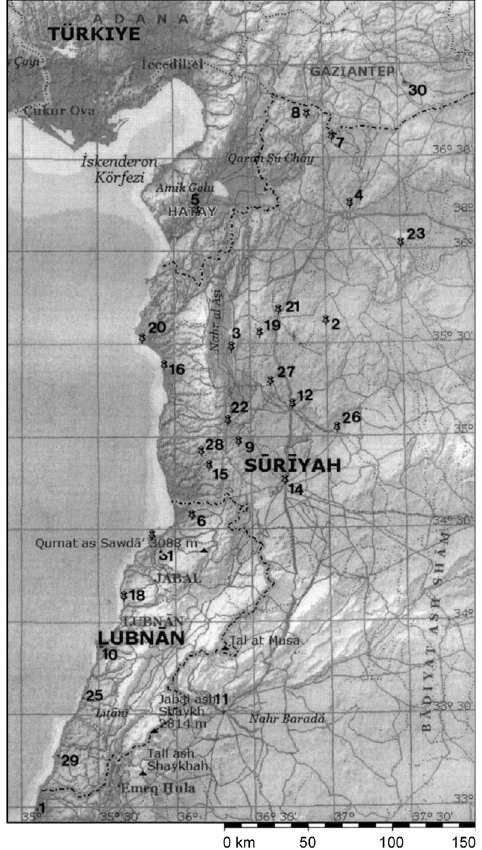
Fig. 4. Location map of the earthquake of 1157. 1 – Acre; 2 – Adad al-Arab; 3 – Afamiya; 4 – Aleppo; 5